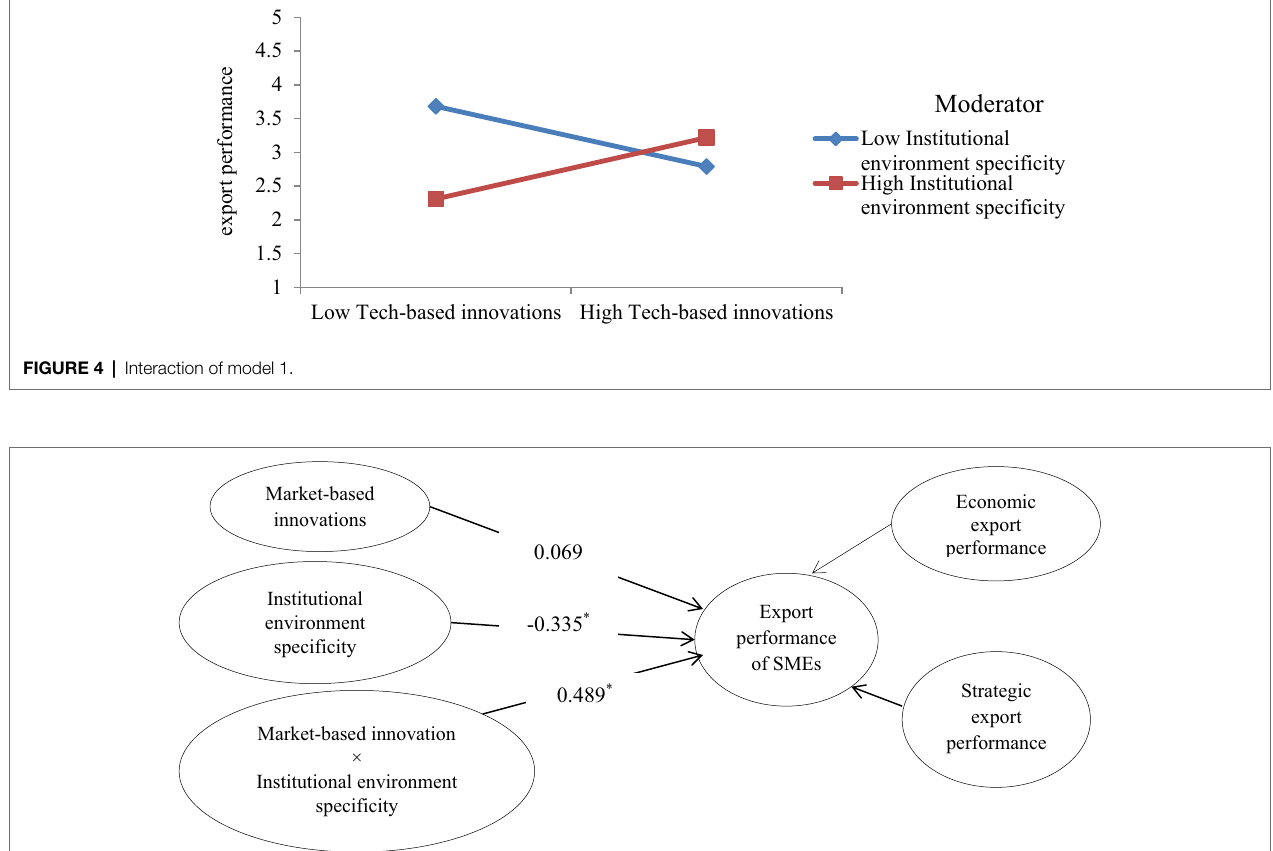
11.522.533.544.55